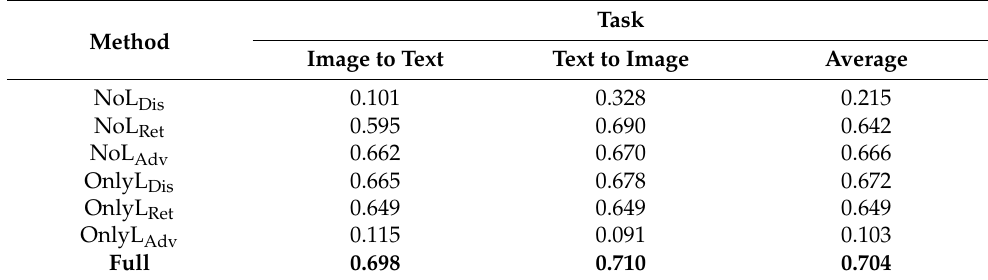
Table 5. The mAP scores of the cross-modal retrieval performance on the Pascal Sentence